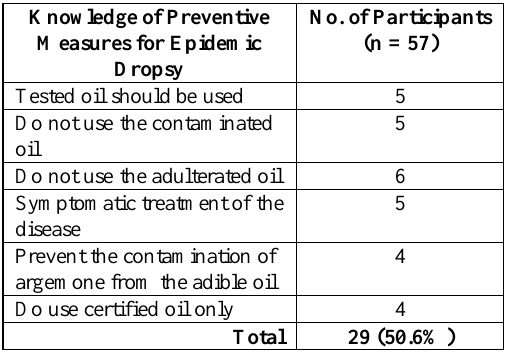
Only 9 (15.8%) health workers knew about the local agencies and laboratories for the testing oil to detect argemone contamination. Fifty percent health worker could identify the preventive measures of epidemic dropsy (Table Table 2. Knowledge regarding preventive measures of epidemic dropsy among the health workers